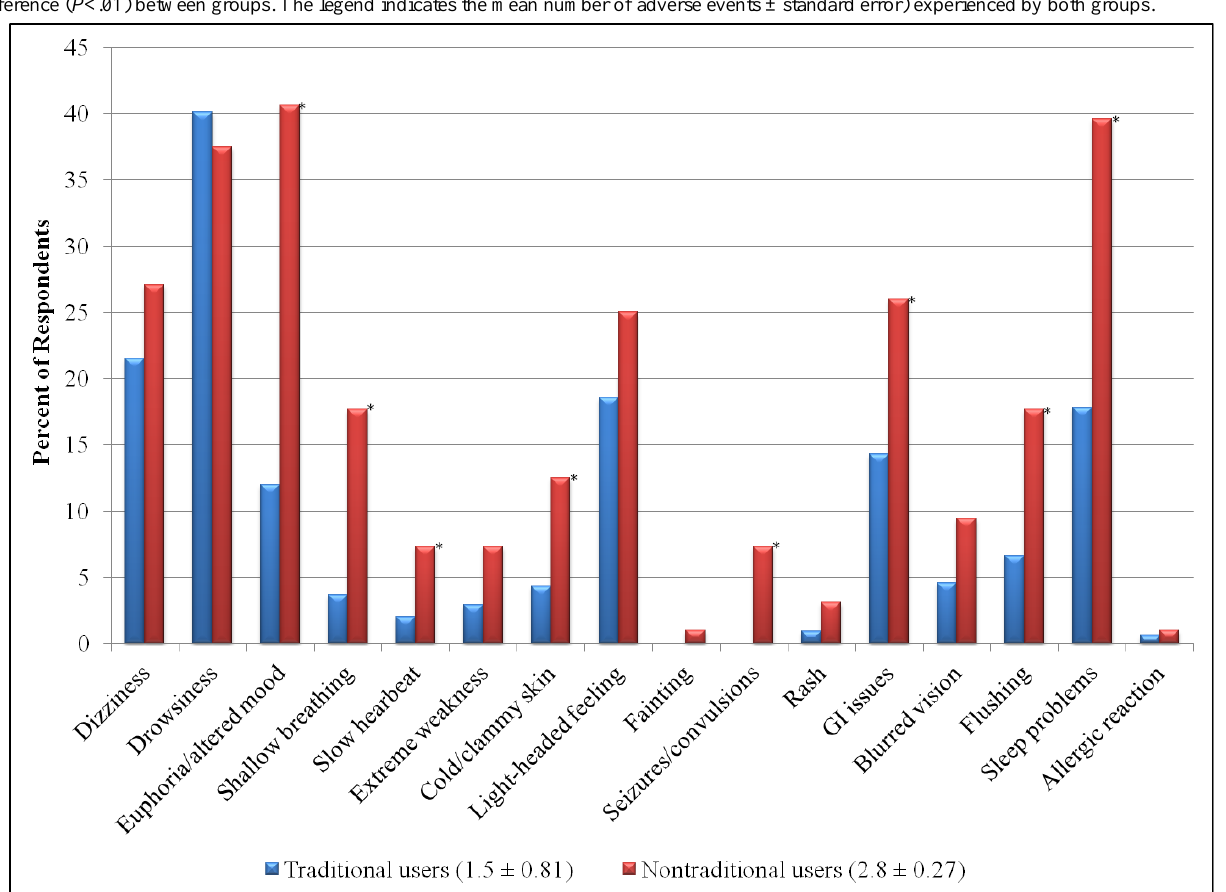
Figure 2. Percent of traditional and nontraditional users who experienced each adverse event while taking tramadol. Asterisks denote a